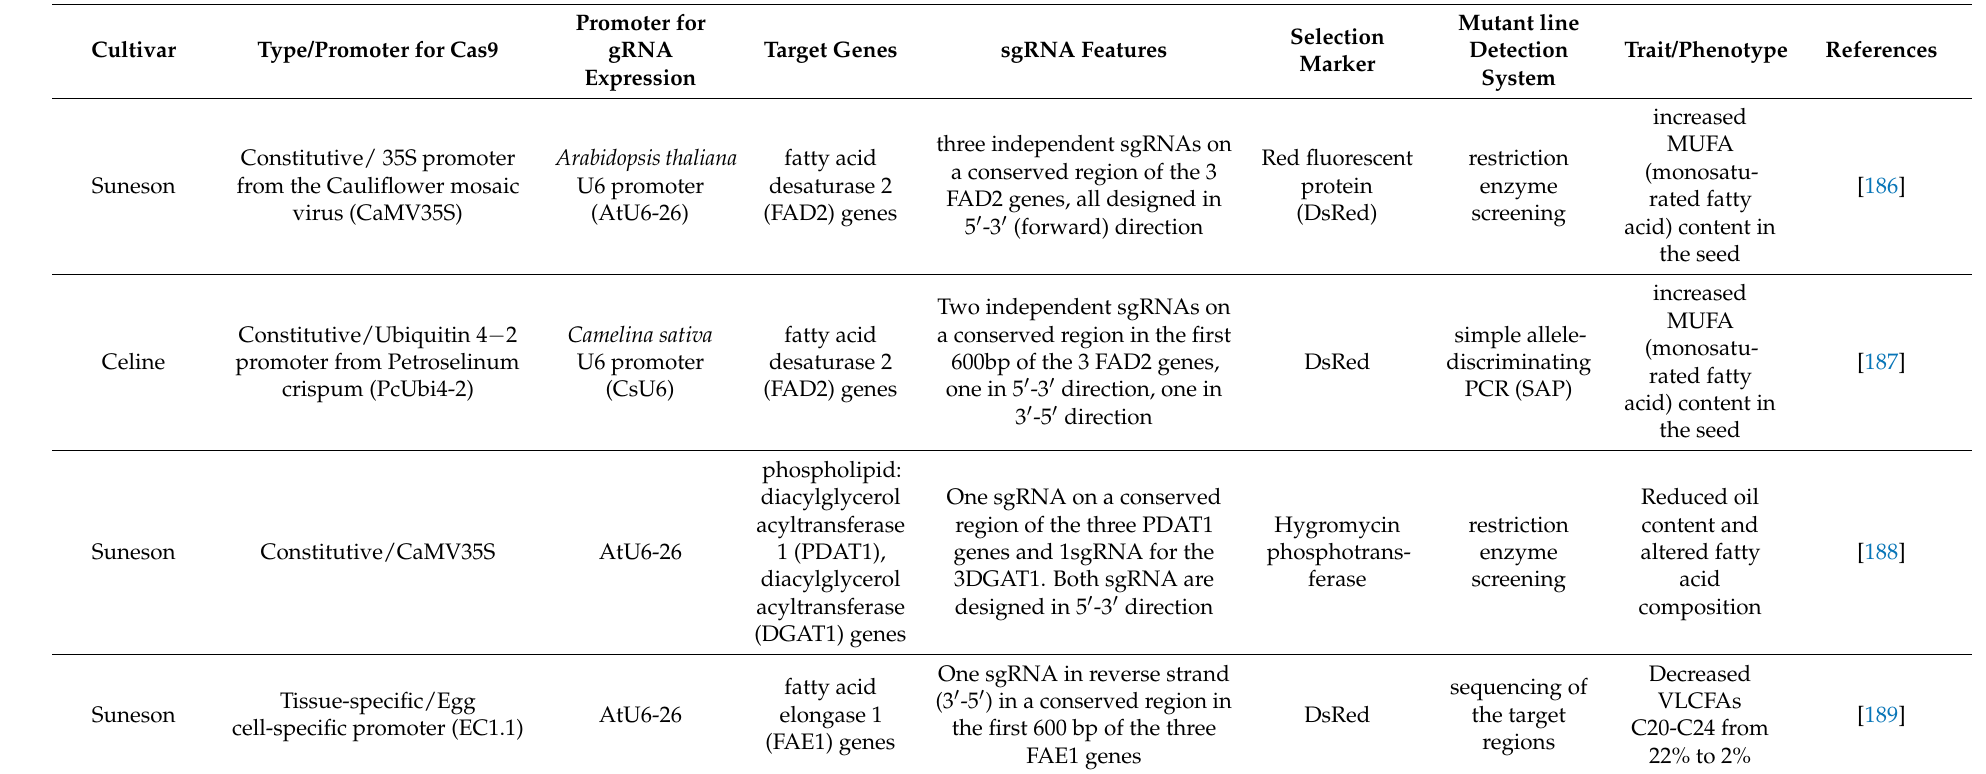
Table 3. Applications of CRISPR/Cas9 editing technology in